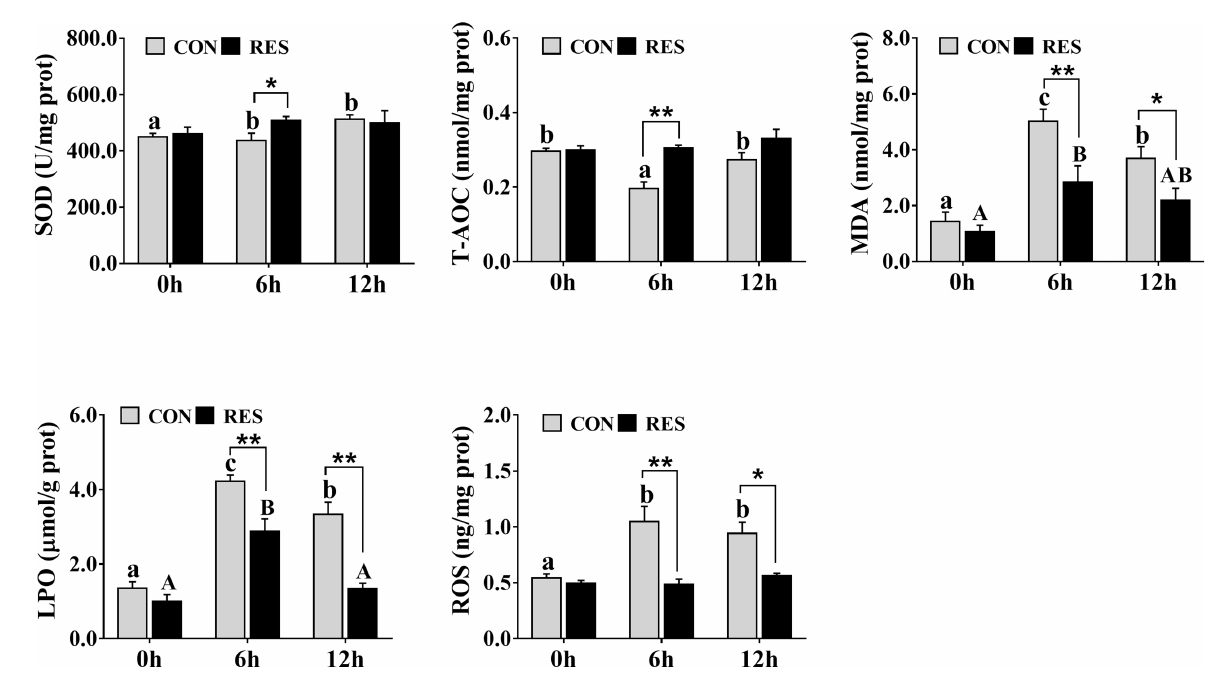
FIGURE 4 Effect of dietary RES on LPS-induced oxidative stress in the liver of gibel carp at 6 h and 12 h after LPS injection. Data are mean ± SEM (n = 6). The lowercase letters represent signi fi cant differences among diverse LPS durations in the CON group ( P < 0.05); the uppercase letters represent signi fi cant differences among diverse LPS durations in the RES group ( P < 0.05). *( P < 0.05) and **( P < 0.01) represent signi fi cant differences between the CON and RES